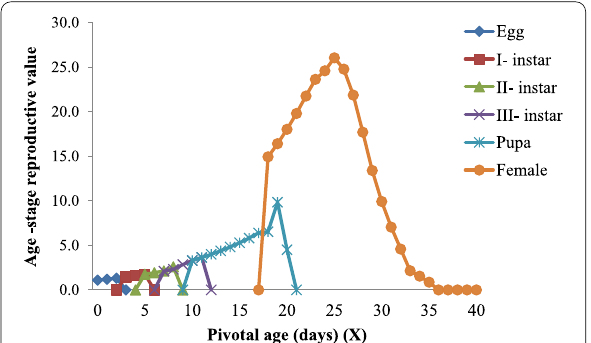
Table 3 Feeding potential of S. pyrastri on cabbage aphid, B.